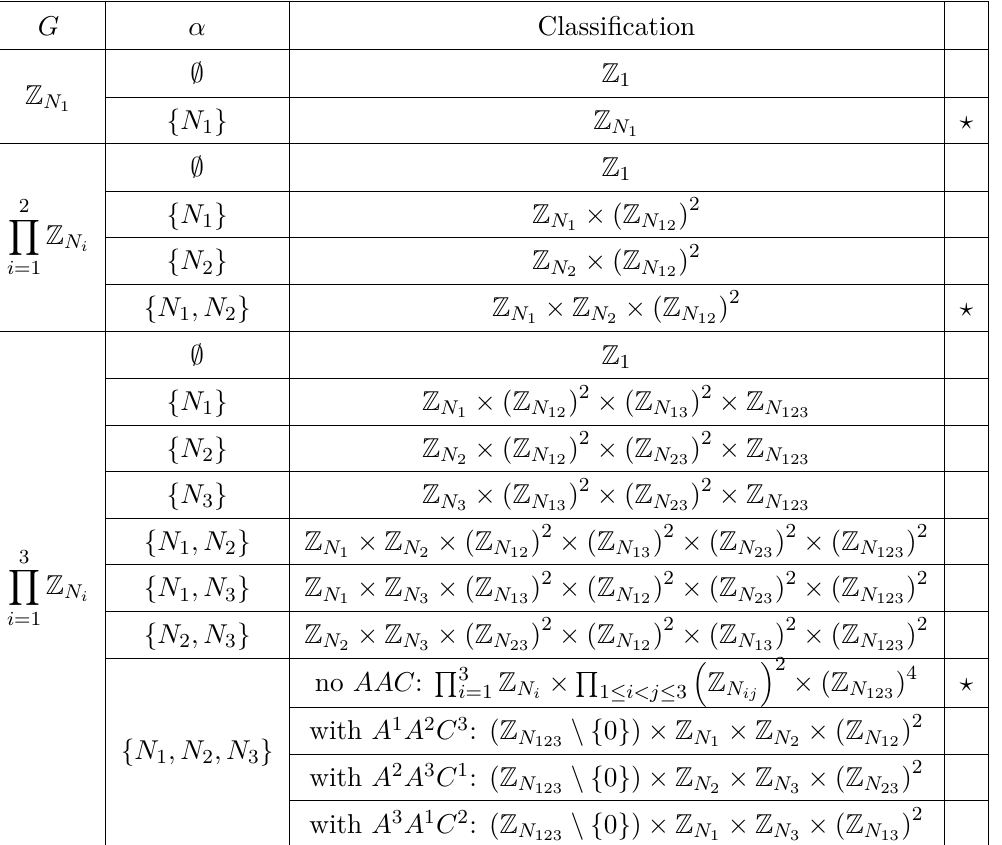
Table 1 . Classification of BF theories with twisted terms for different gauge groups G , which are detailed in sections 3.1, 3.2, and 3.3. α is a set, which denotes Z N gauge subgroups that are i encoded in the type-I BF term, e.g., α = { N 1 , N 2 } means N 1 C 1 dA 1 + N 2 C 2 dA 2 . Only a part 2 π 2 π of 5 D BF theories, denoted by a ? symbol, are consistent with Dijkgraaf-Witten cohomological classification, i.e., H 5 ( G, R / Z ) . The remaining are beyond the group cohomology classification. Z When G = Q 3 N i and α = { N 1 , N 2 , N 3 } , depending on different choices of AAC term, the i =1 actions and their classification are different, as discussed in section 3.3. The reason is that AAC term may be incompatible with other twisted terms, hence cannot be included in the